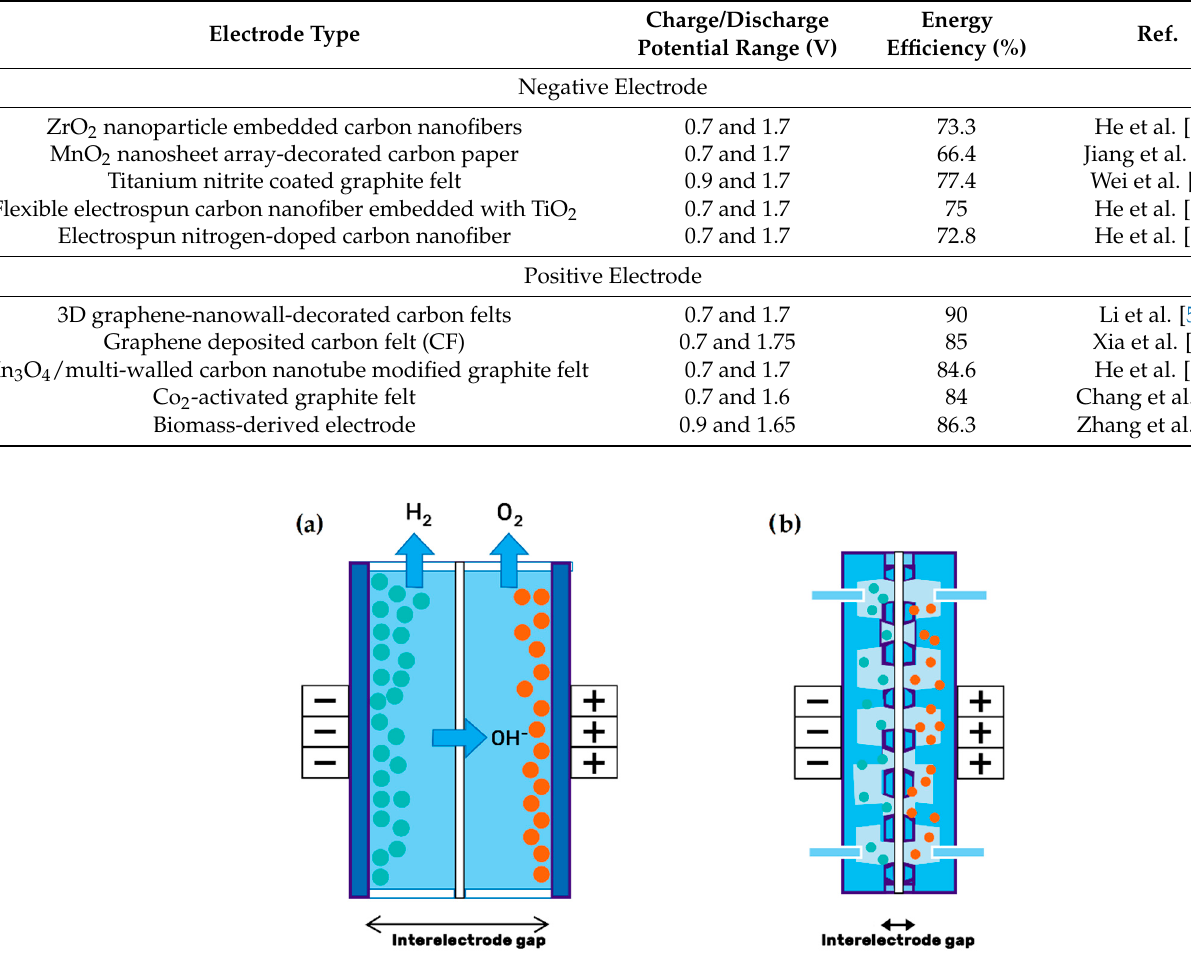
Redrawn from Redrawn from [64].